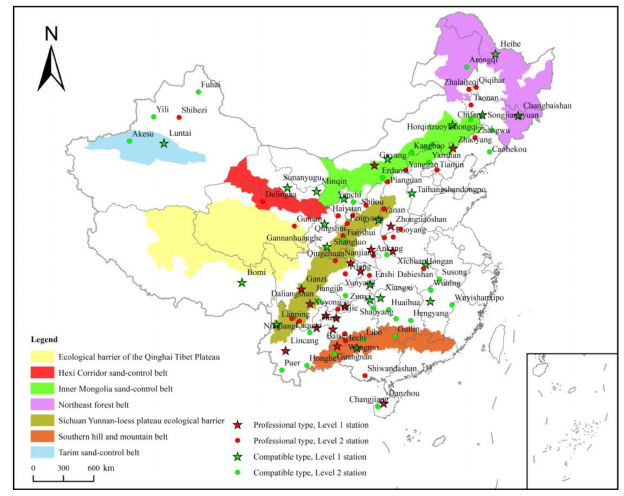
Figure 6. The layout of monitoring stations in the ecological barrier areas.